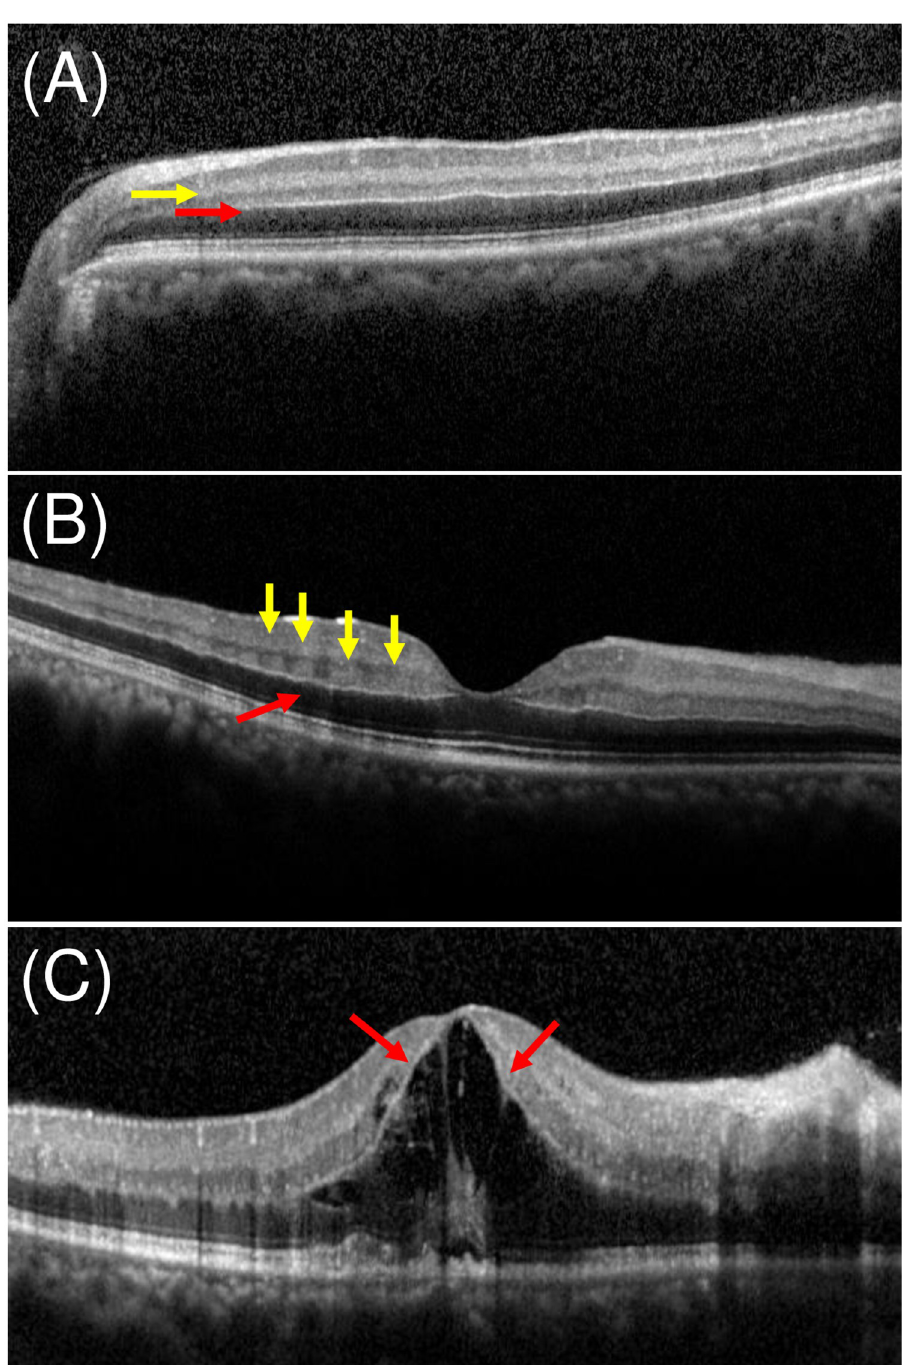
Fig 1. Three types of relationships between PAMM and p-MLM sign. Yellow arrows indicate PAMM lesions and red arrows indicate the hyperreflective line of p-MLM sign. A. Diffuse PAMM lesions and p-MLM sign. B. Skip PAMM lesions and p-MLM sign. C. p-MLM sign only. PAMM: paracentral acute middle maculopathy, p-MLM: prominent middle limiting membrane.